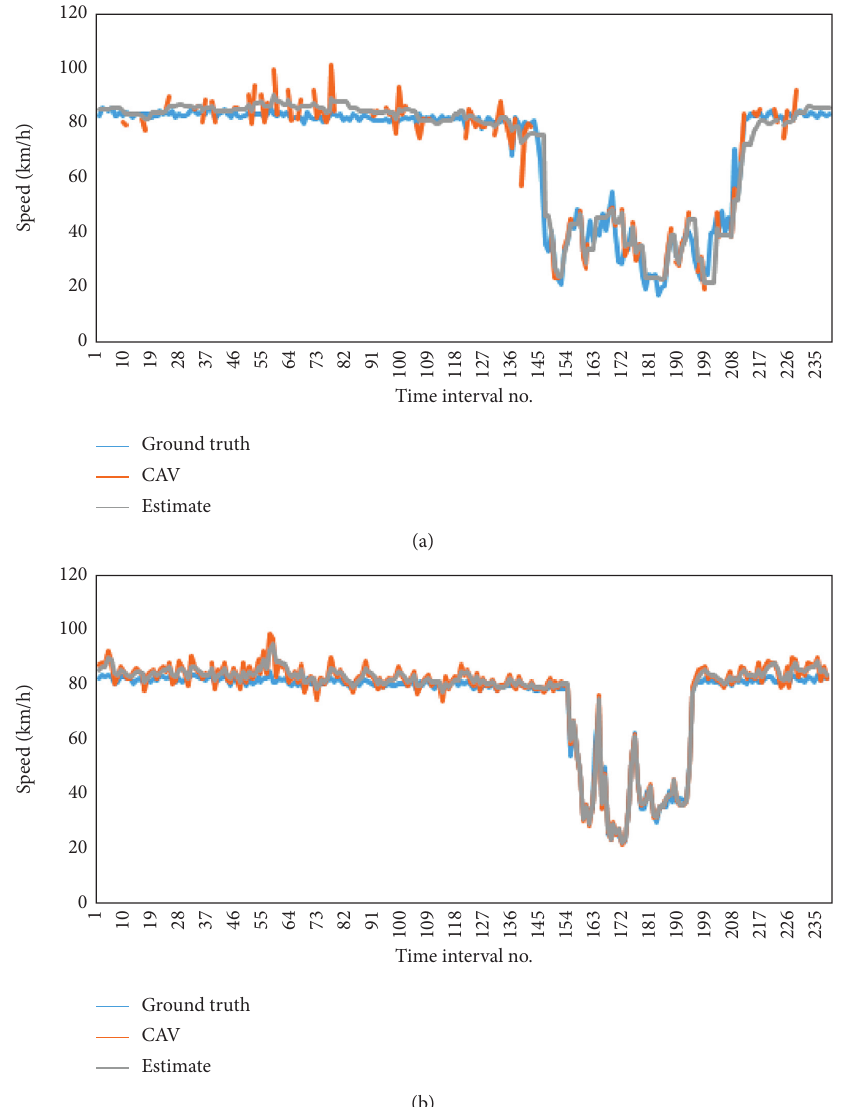
Figure 6: Ground-truth speeds, CAV speeds, and estimated speeds on Link 7. (a) CAVs account for 1%. (b) CAVs account for